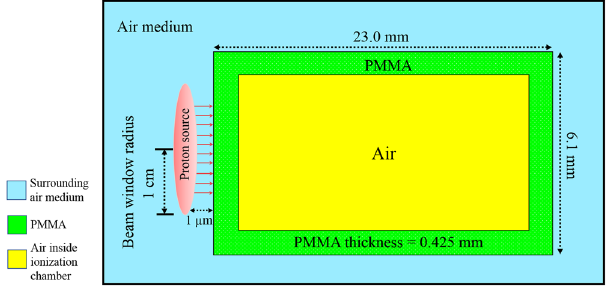
Figure 2. Schematic representation of the proton irradiation of the ionization